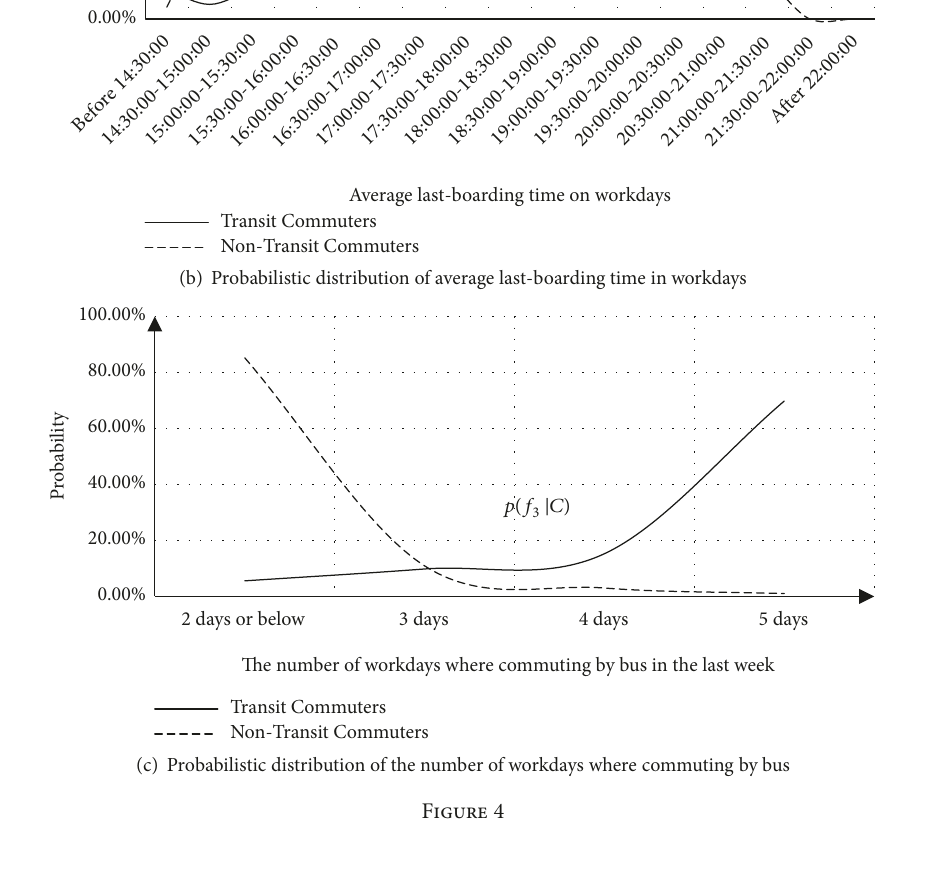
Table 4: Identification results of the NBC model.